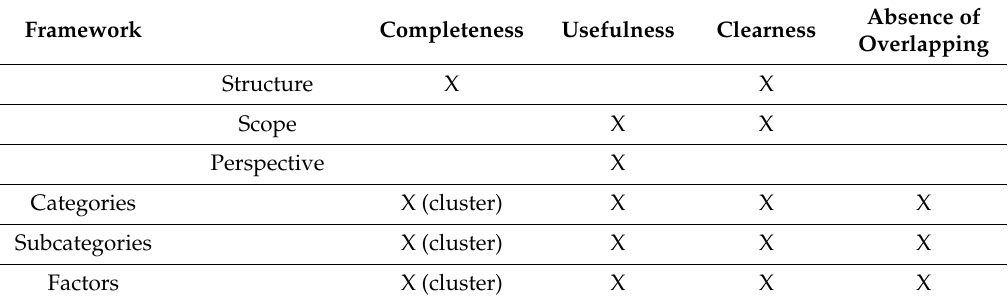
Table 6. Parameters for the framework